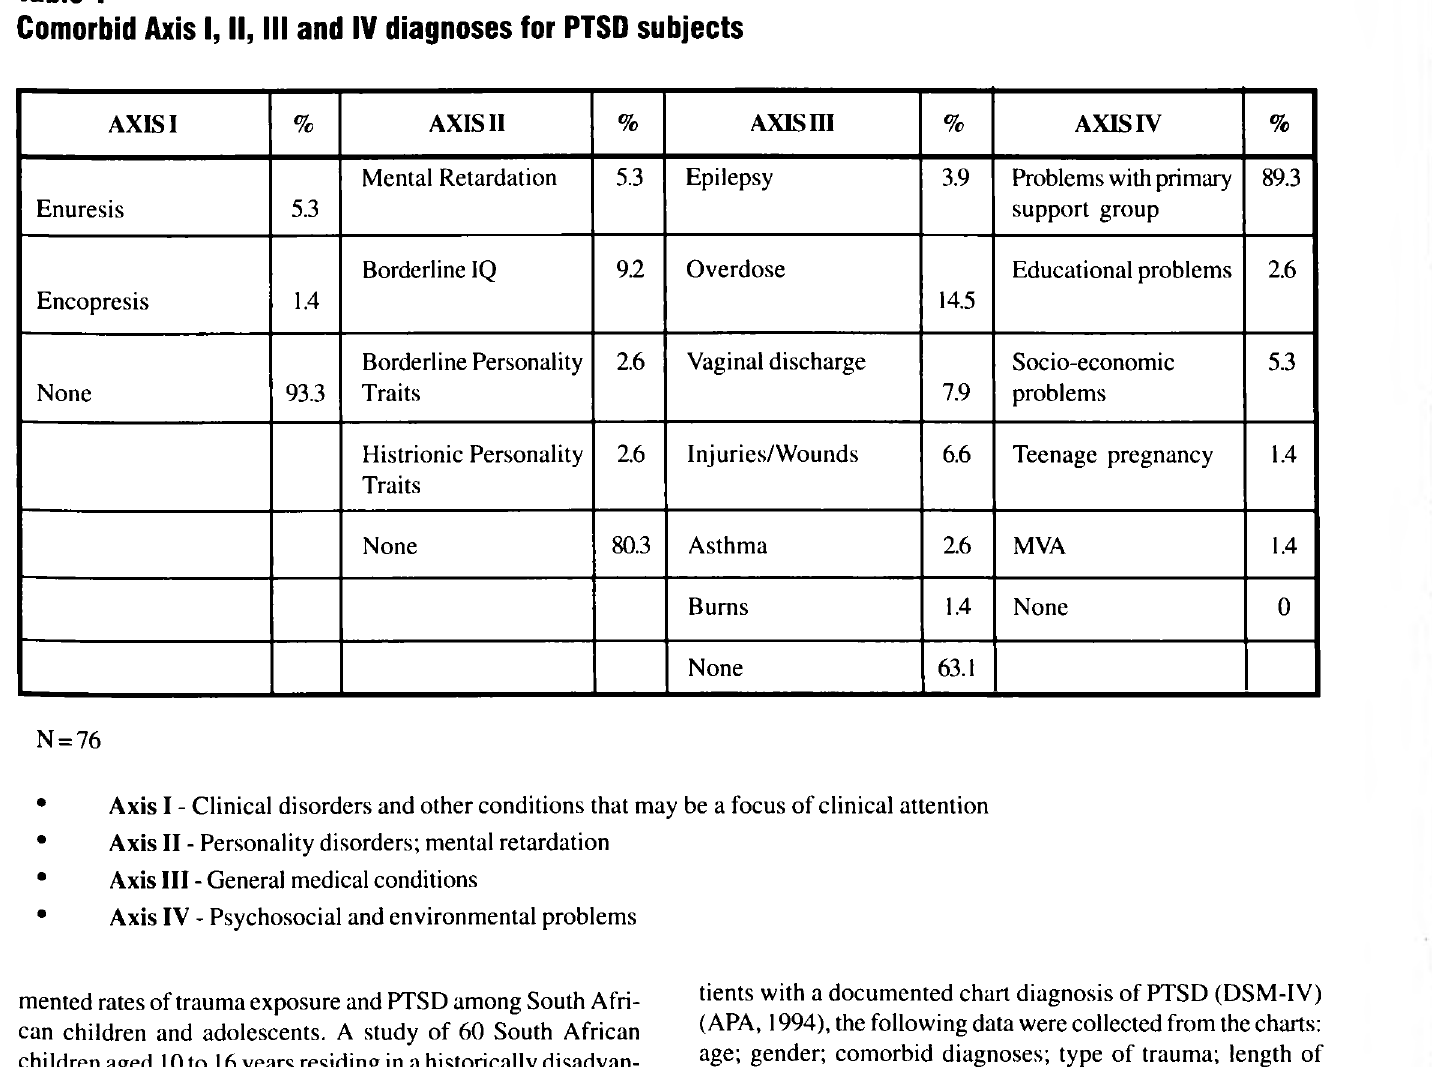
Comorbid Axis I, II, III and IV diagnoses for PTSD subjects